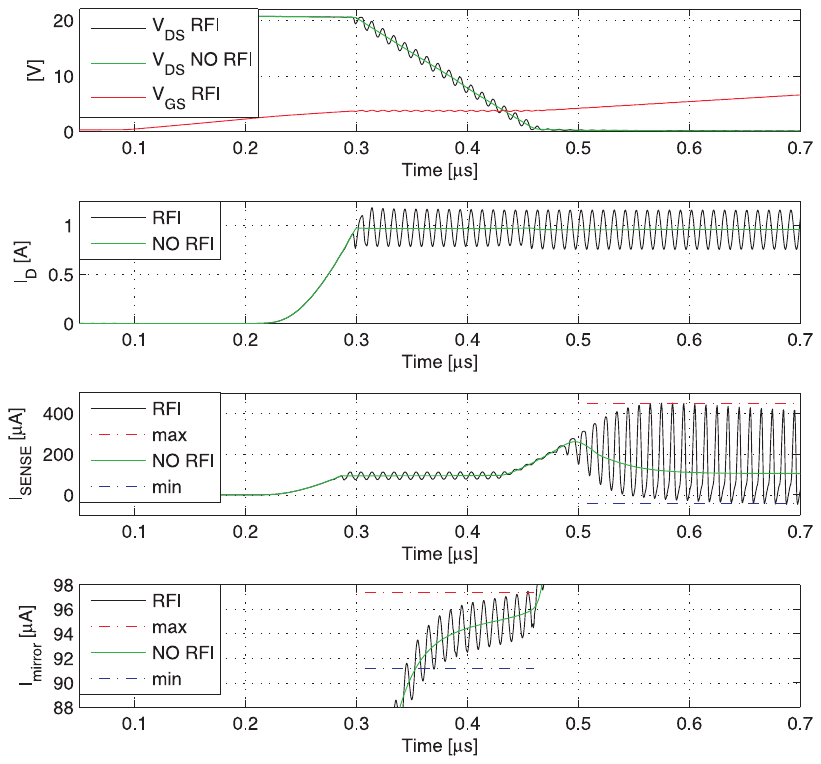
, V , I ) and the respective DS GS D ) and the new sensor based on SENSE